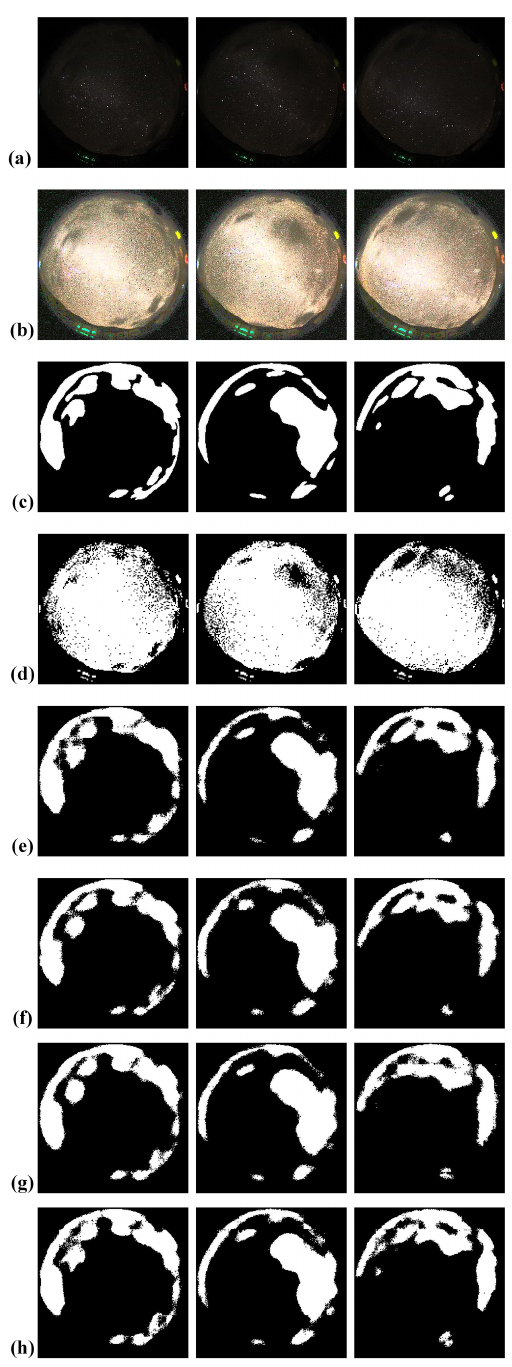
Figure 7. Results of different cloud segmentation algorithms. (a) Original nocturnal ASI images, (b) enhanced nocturnal ASI images, (c) ground truth of the corresponding ASI images in (a) , (d) results of OTSU, (e) results of EFCN-32s, (f) results of EFCN- 16s, (g) results of FCN-8s, and (h) results of the proposed EFCN-8s.